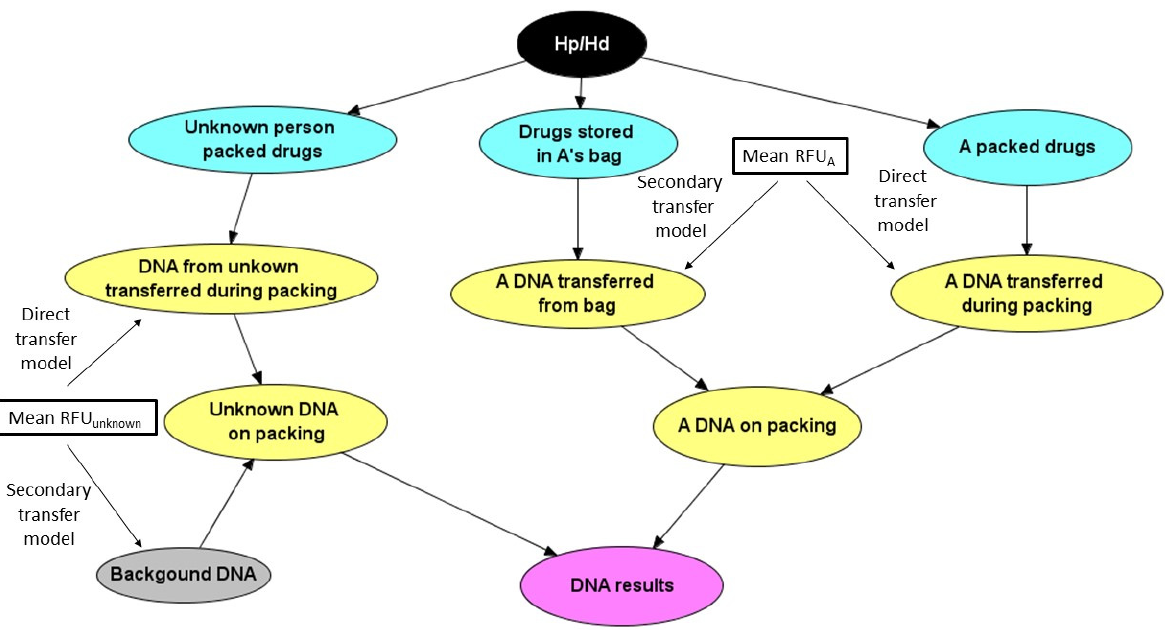
Table 2. Relationship of probabilities of DNA transfer from individuals A (POI) and U (unknown), showing the datasets that were used to calculate probability distributions, along with the BN nodes instantiated. See nomenclature Section 2.5.1 for definitions of probabilities.